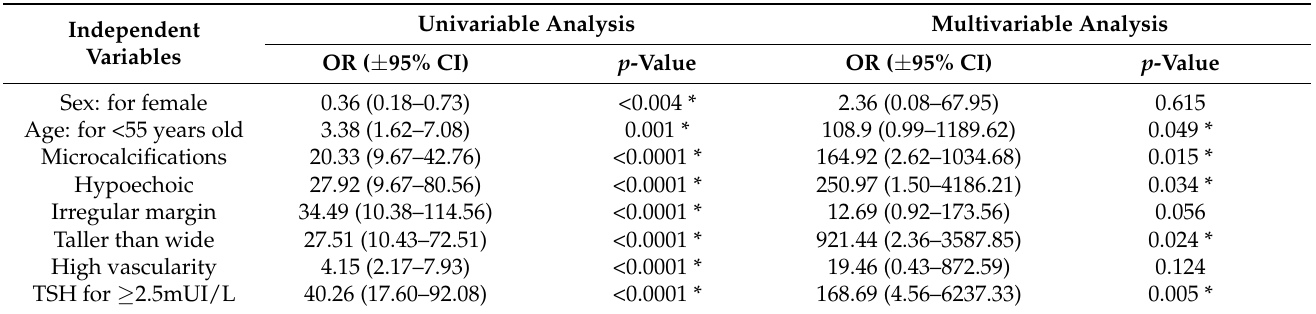
Table 4. Univariable and multivariable logistic regression analysis of selected predictors of malig- nancy (benign/cancer; 0/1) in patients with AUS/FLUS thyroid tumor